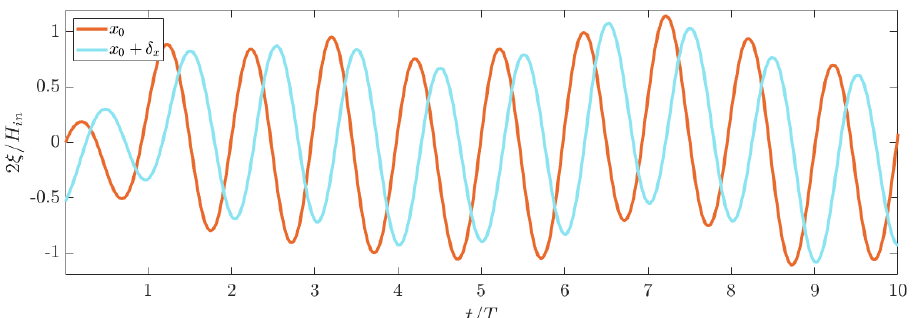
Figure 5. Wave motion at two different points of the viscoelastic cover. The data are related to the waves with a period of 0.65 s. Here, 𝐻 𝑖𝑛 is the height of the incoming wave.